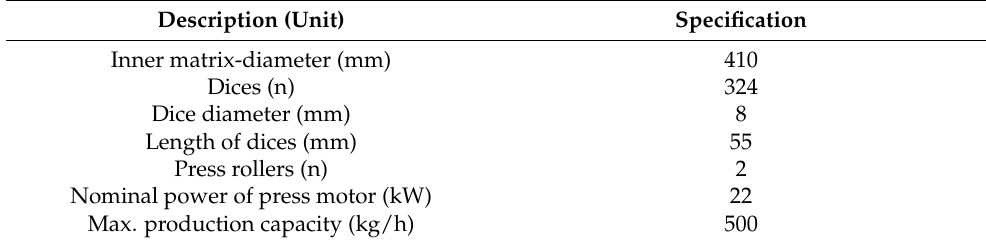
Table 3. Pelletizer